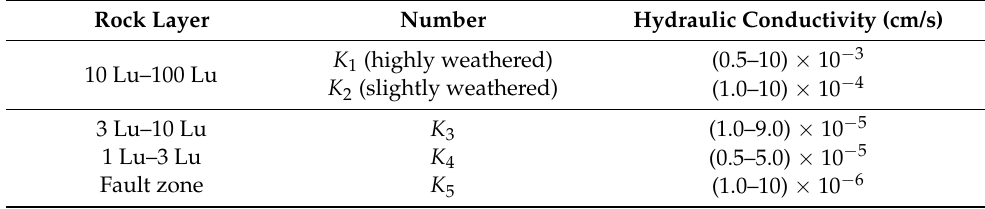
Figure 4. Location of the Hami concrete-face rockfill dam. Table 1. The range of the Hami dam foundation’s hydraulic conductivity.